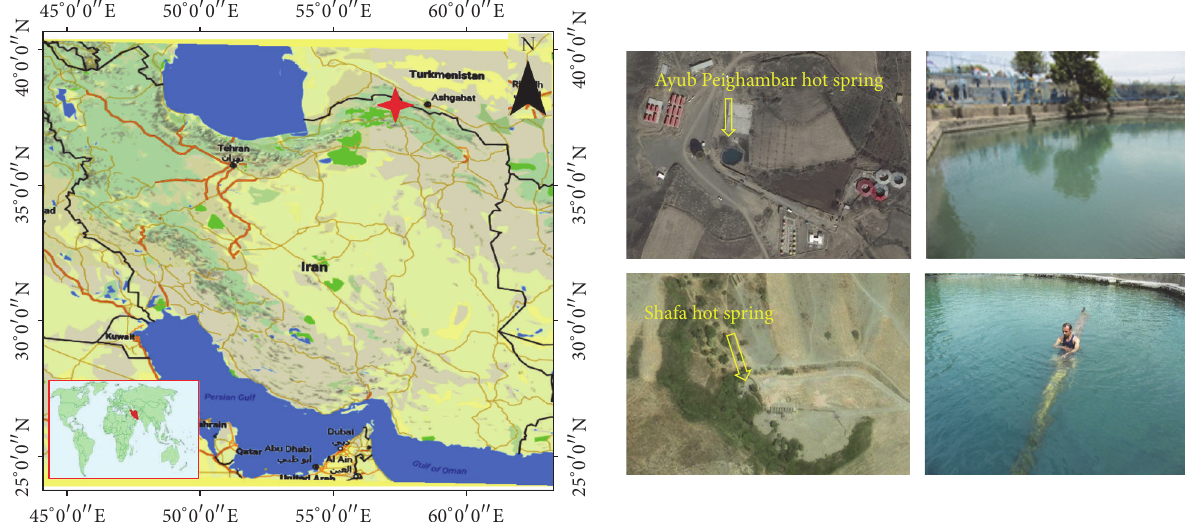
Figure 1: The study area and the locations of the Ayub-Peighambar and Shafa (AP and SH) hot